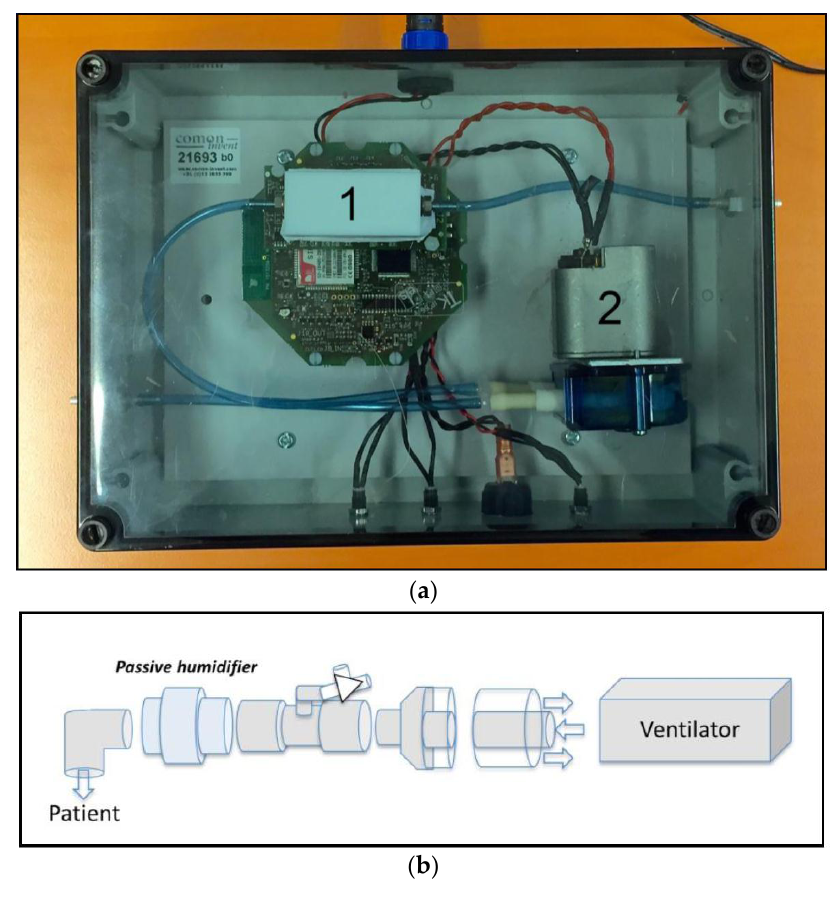
Figure 1. eNose and Side stream of the that is created to connect the eNose. In the upper panel ( a ), the eNose that is used in our study is pictured: (1) is the sensor block containing the metal oxide sensors; and (2) is the pump that is used to pump exhaled breath over the metal oxide sensors. The lower panel ( b ) illustrates the side stream of that is created to connect the eNose. A T-piece is connected distal of the heat moist exchanger in the ventilation circuit.